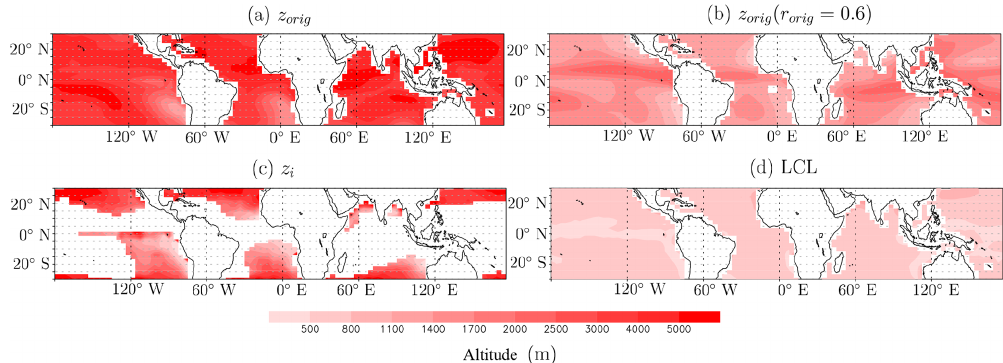
Figure 11. (a) Map of winter-mean z orig estimated from δD 0 simulated by LMDZ. (b) Same as (a) but z orig that we would estimate if r orig were constant set to 0.6, z orig (r orig = 0 . 6 ) . (c) Same as (a) but for z i simulated from LMDZ. Only days when EIS > 2K are considered, otherwise z i is difficult to estimate. (d) Same as (a) but for LCL simulated by LMDZ.